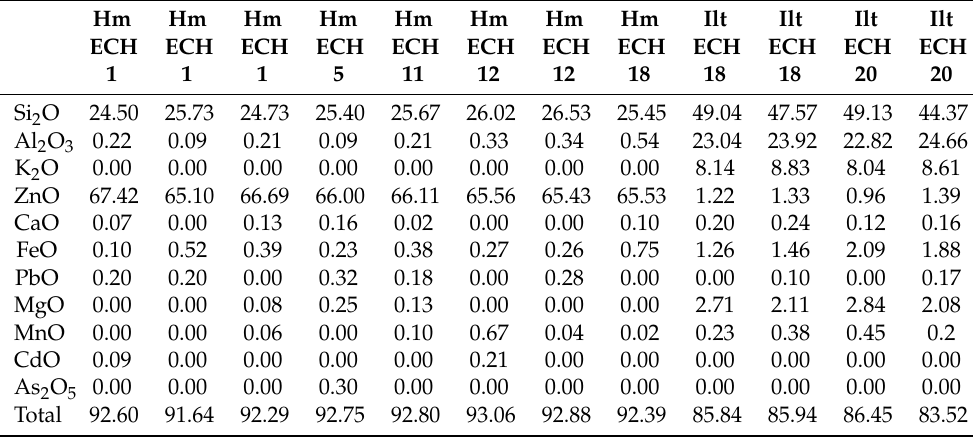
Table 2. Chemical composition of selected silicates from the nonsulfide ore association (Hm: hemi-